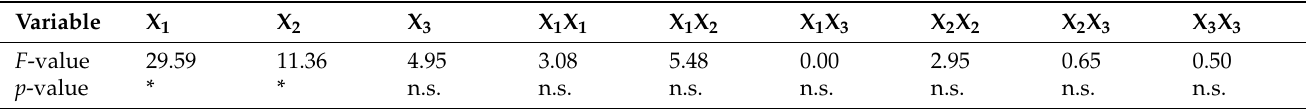
Table 4. F and p -values for selected responses for each obtained